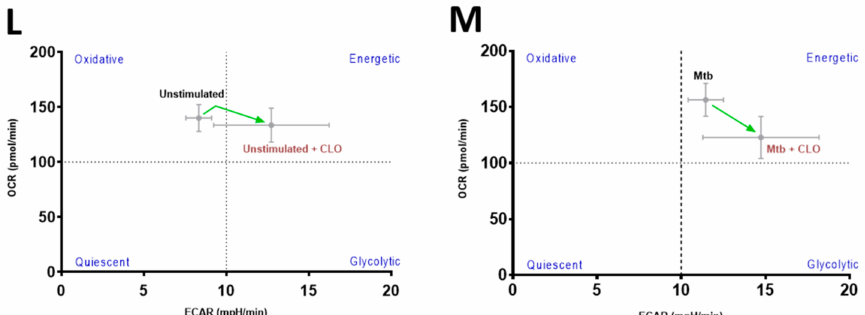
Figure 3. Clofazimine treated hMDMs stimulated with iH37Rv-Mtb rely on glycolysis by promoting Warburg metabolism. hMDMs, differentiated from PBMCs isolated from healthy blood donors, were treated with ( A ) ethambutol (5 µ g/mL), ( B ) isoniazid (1 µ g/mL), ( C ) pyrazinamide (2 µ g/mL), ( D ) rifampicin (2 µ g/mL), ( E ) amikacin (5 µ g/mL), ( F ) bedaquiline (5 µ g/mL), ( G ) clofazimine (2 µ g/mL), ( H ) cycloserine (5 µ g/mL), ( I ) linezolid (15 µ g/mL) or ( J ) moxifloxacin (12.5 µ g/mL) three hours post stimulation with either iH37Rv-Mtb or LPS (100 ng/mL). At 24 h post stimulation, the ECAR:OCR ratio was generated to measure the reliance of one metabolic pathway over another. ( K ) Summary of how clofazimine affects the ECAR:OCR ratio in unstimulated and iH37Rv-Mtb- stimulated hMDMs. This immunometabolic shift as a result of clofazimine treatment is illustrated by a metabolic phenogram in ( L ) unstimulated and ( M ) Mtb-stimulated hMDMs. Bars denote mean ± SEM * p < 0.05 and ** p < 0.01 (Two-way repeated measures ANOVA with Sidak’s multiple comparisons test). Ethambutol (EMB, n = 7); isoniazid (INH, n = 8); pyrazinamide (PYZ, n = 7); rifampicin (RIF, n = 9); amikacin (AMK, n = 5); bedaquiline (BDQ, n = 6); clofazimine (CLO, n = 6); cycloserine (CYS, n = 4); linezolid (LIN, n = 8); moxifloxacin (MOX, n =